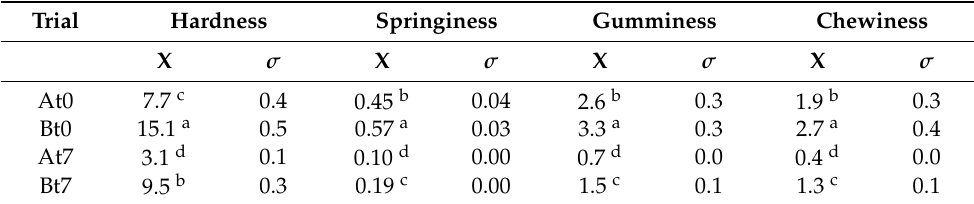
Table 2. Hardness, springiness, gumminess, and chewiness of experimental goat mozzarella at 0 and 7 days refrigerated storage. X = mean value; σ = standard deviation. Values in the same column bearing different superscripts are different at p <